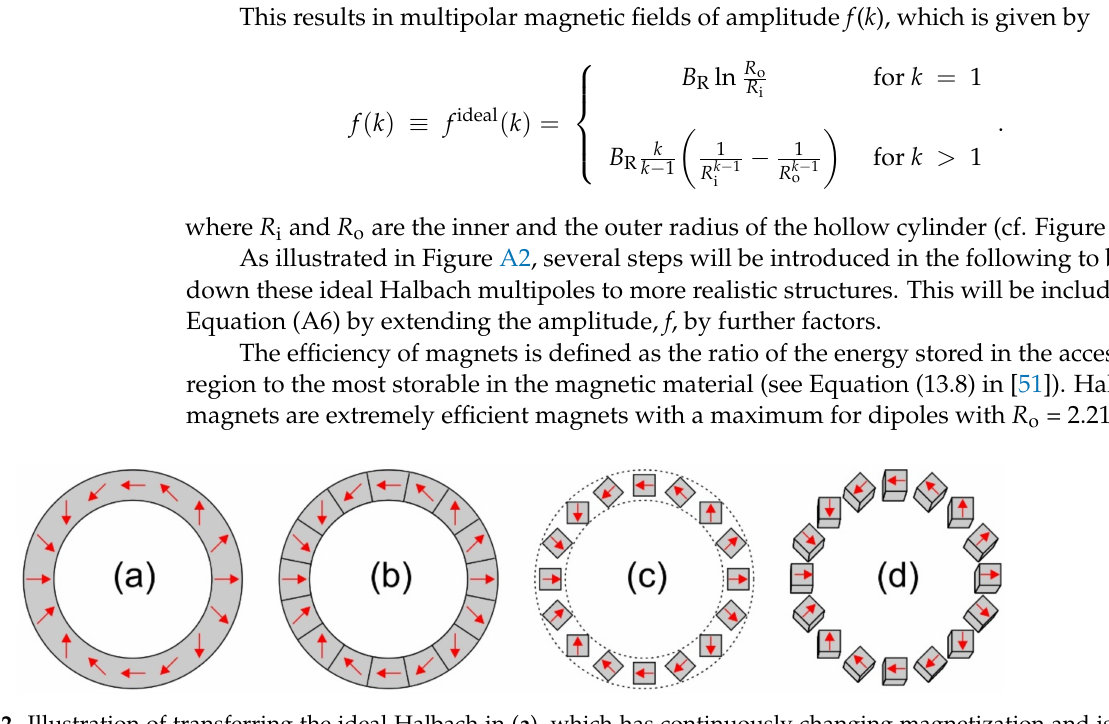
Figure A2. Illustration of transferring the ideal Halbach in ( a ), which has continuously changing magnetization and is infinitely long, into a real system. ( b ) First the magnet is discretized into N cylinder-segments with one, homogeneous magnetization direction. ( c ) The cylinder segments can be replaced by identical magnets that are rotated to the correct magnetization direction. ( d ) Finally the arrangement is truncated to finite